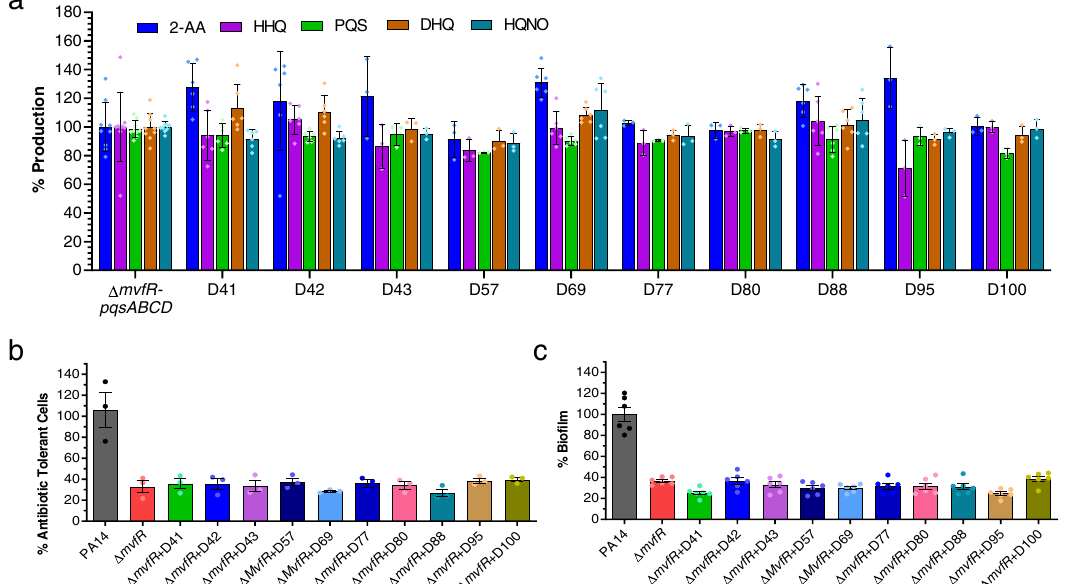
Fig. 4 | In vitro assessment of NAMs ef fi cacy indicates no off-target effect. a Effect of the selected compounds on the MvfR-independent HAQs, 2-AA, and DHQ production. The production of the MvfR-regulated small molecules 2-AA, HHQ, PQS, DHQ, and HQNO was measured in the cultures at OD 600nm =3.0 in the presence of 50 µ M of the indicated compounds using a MvfR mutant strain that constitutivelyexpressesthe pqsABCDE genes.Thecellsweregrownwithorwithout (vehicleonly)compound,andthesmallmoleculesproductionwasmeasuredusing liquid chromatography-mass spectrophotometry (LC-MS). The percentage pro- duction was calculated compared to cells grown with the vehicle control. b AT/P cell formation in the PA14 isogenic mutant Δ mvfR in the presence of the indicated compounds. Cells were grown in the presence of 10 μ gmL − 1 meropenem, with or without 10 µ M of the compounds for 24h. Values were normalized to cells grown for 4h in the absence of antibiotics and compounds. The Δ mvfR cells grown with